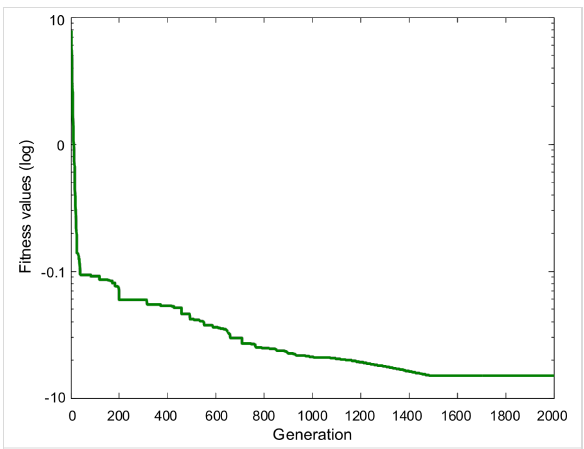
Figure 6: The convergence profile of the optimization of the proposed model using ACO technique.